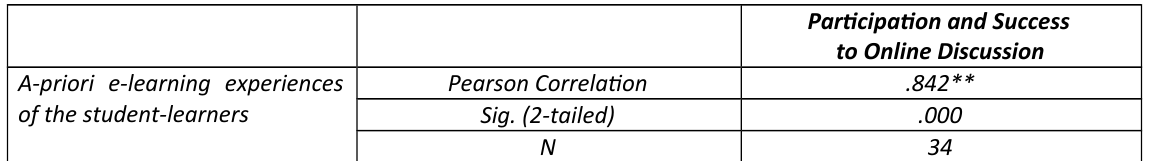
Table 2. The Relationship between the Students’ A-priori Experiences and the Characteristics of their Success